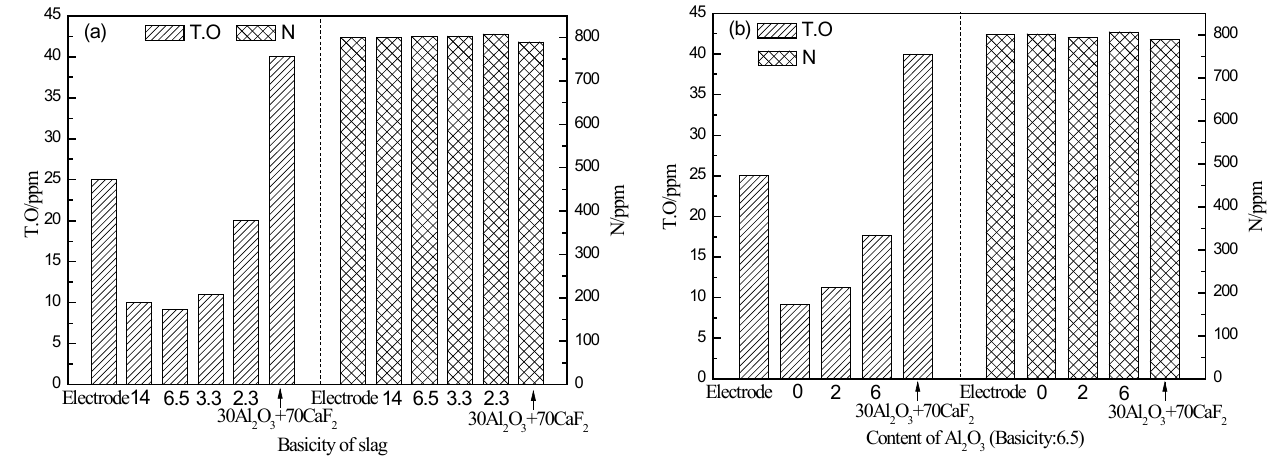
Figure 3. Effect of slag composition on oxygen and nitrogen content of electroslag ingot . ( a ) Effect of basicity on oxygen and nitrogen content. ( b ) Effect of Al 2 O 3 content in the slag on oxygen and nitrogen content.